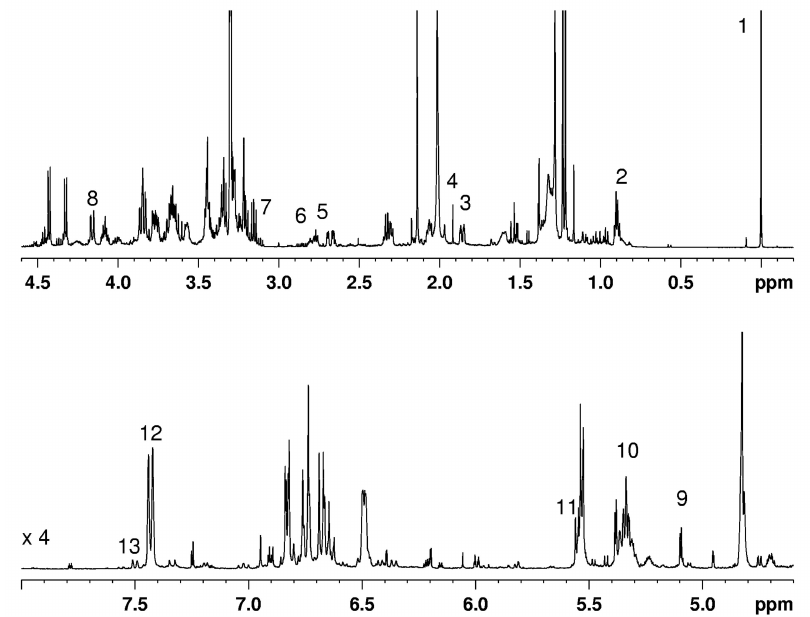
Figure 1. 1 H NMR spectrum of Lebanese saffron extract in CD 3 OD at 27 ◦ C. Assignment: (1) CH 3 of TSP; (2) CH 3 of FA; (3) CH 2 -5 PCROC; (4) CH 3 AcOH; (5) CH 2 -11 C18:2; (6) CH 2 -11,14 C18:3; (7) CH-2 β GLC; (8) CH α GLC; (10) CH=CH UFA; (11) CH-1 β LC-Croc; (12) CH-10,10 (cid:48) 2 -6 GB-Croc; (9) CH-1 all trans-crocin DBtCroc; (13) CH-10 cis-crocin DBcCroc.